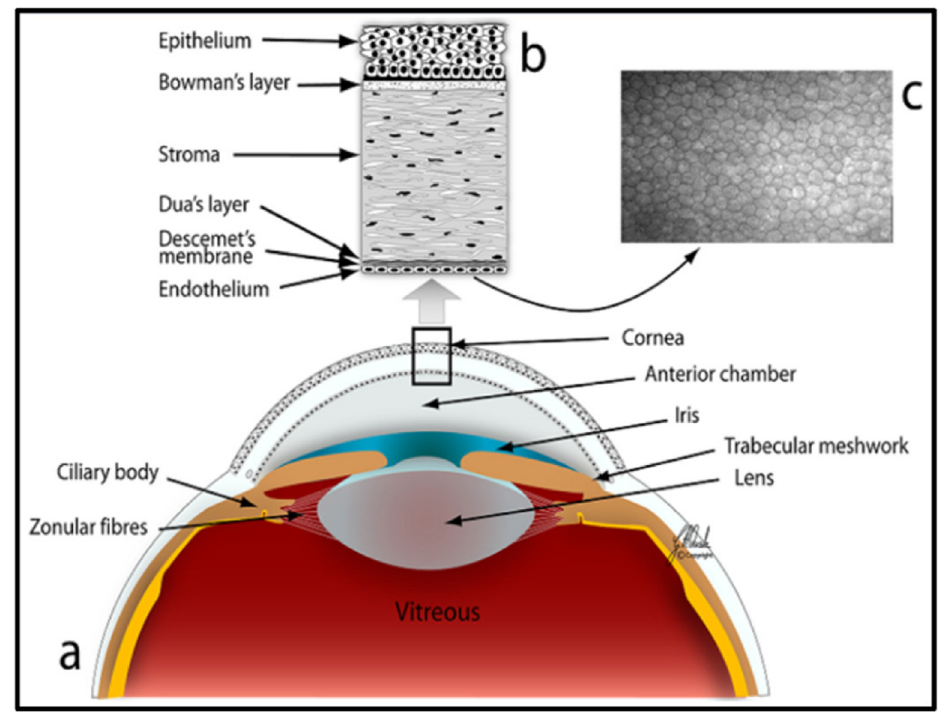
Figure 1: The anatomy of the human eye and the cornea ( a ) section of the frontal part of the human eye, ( b ) six layers from the anterior to the posterior cornea, and ( c ) in vivo corneal confocal microscopy image of the corneal endothelium